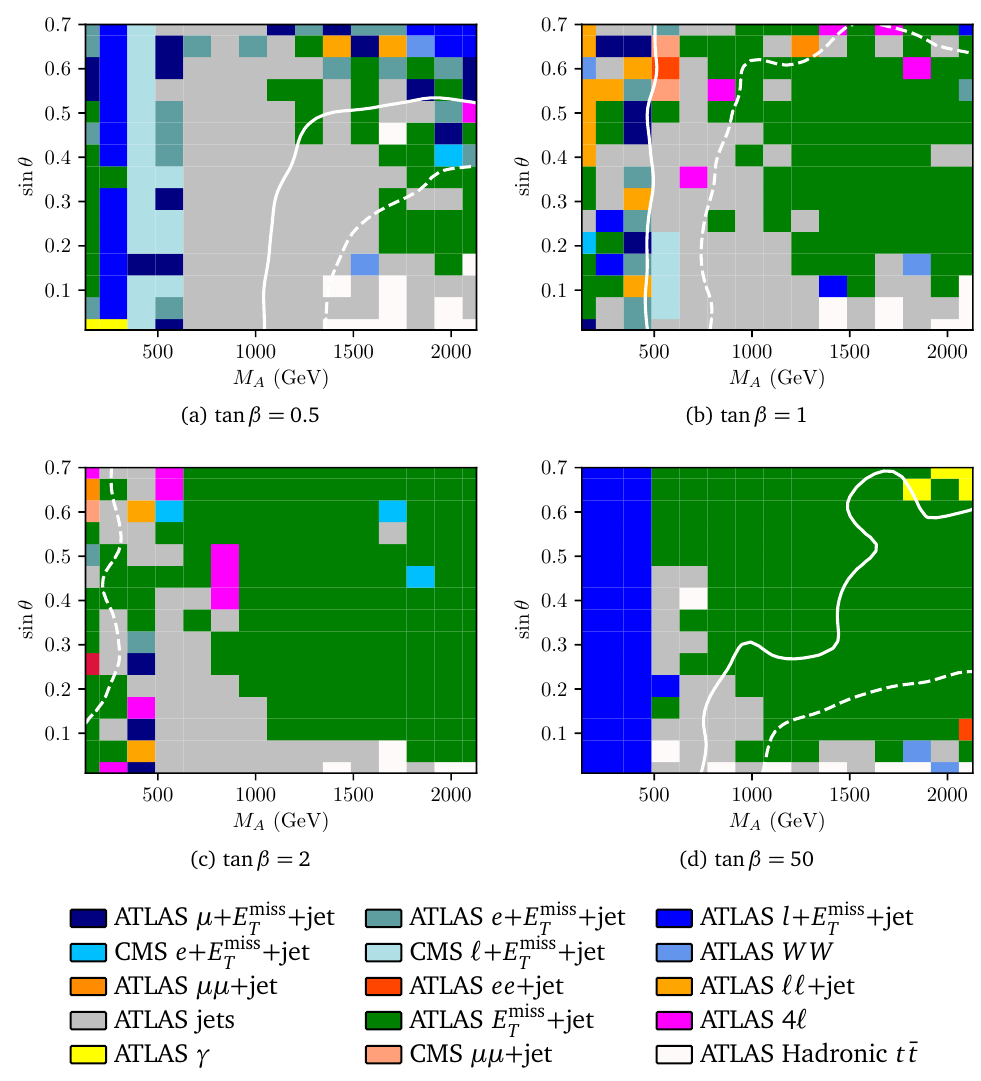
Figure 7: Scans in the common mass of the exotic Higgs bosons and mixing angle = 400GeV. All other parameters sin θ between a and A for different tan β with M a are as given in Table 1. The 95% (68%) excluded contours are indicated by solid (dashed) white lines; note that there is no exclusion at 95% confidence level for tan β = 2. The colours indicate the most sensitive set of